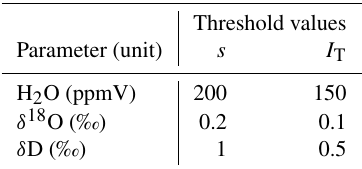
Table 1. Threshold values for standard deviation s and trend index I T used for automated detection of stable measurement